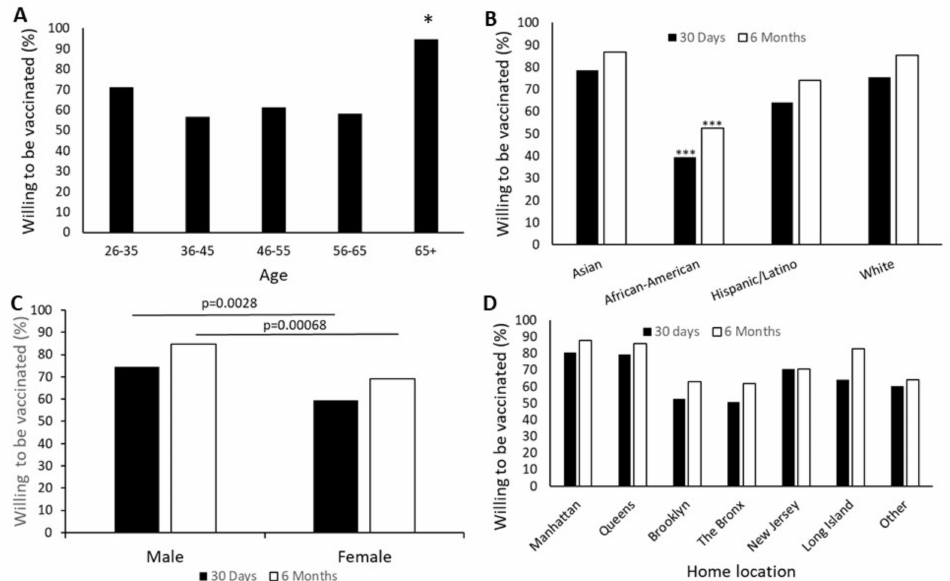
Figure 1. Demographic influences on vaccine acceptance. Willingness to be vaccinated was evaluated using the questions “In the next 30 days . . . ” or “In the next 6 months . . . ” with responses being “I plan to vaccinate myself” or “I will not vaccinate myself.” ( A ) Significantly more subjects over the age of 65 were planning to be vaccinated within 30 days than any other group (Overall, χ 2 = 14.65, p = 0.005, comparison of 65+ to each other group (*) p < 0.030). This difference disappeared when the time frame was extended to six months. ( B ) African American participants were significantly less likely to plan on vaccination than any other ethnic group within either 30 days or six months (*** p < 0.0003), ( C ) Women were less likely than men to accept vaccination within either time frame ( p < 0.001). ( D ) Location of a person’s home was statistically meaningful in COVID-19 vaccination intention during both time frames ( χ 2 > 26, p < 0.0003). n =